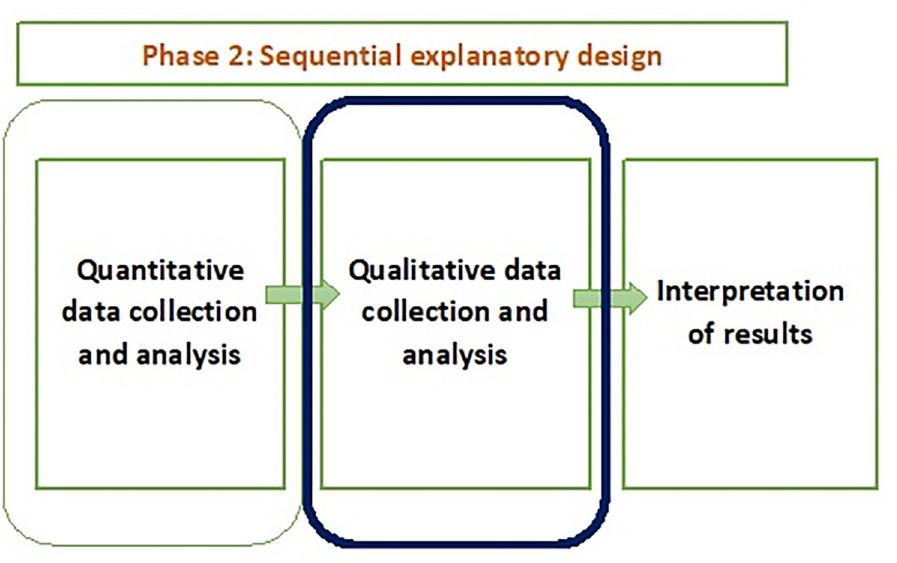
Fig 2. Phase 2 of the FAST-M intervention